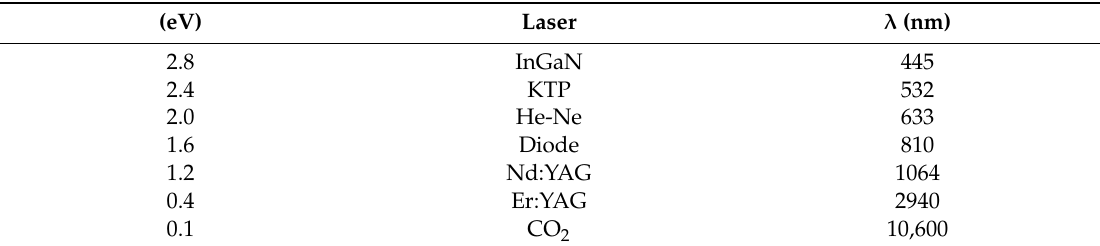
Table 1. Commonly used laser wavelengths associated with dental treatment. Photonic energy and wavelength are inversely related. With ascending numerical values of wavelength, the corresponding photonic energy (expressed as electron volt—eV) is